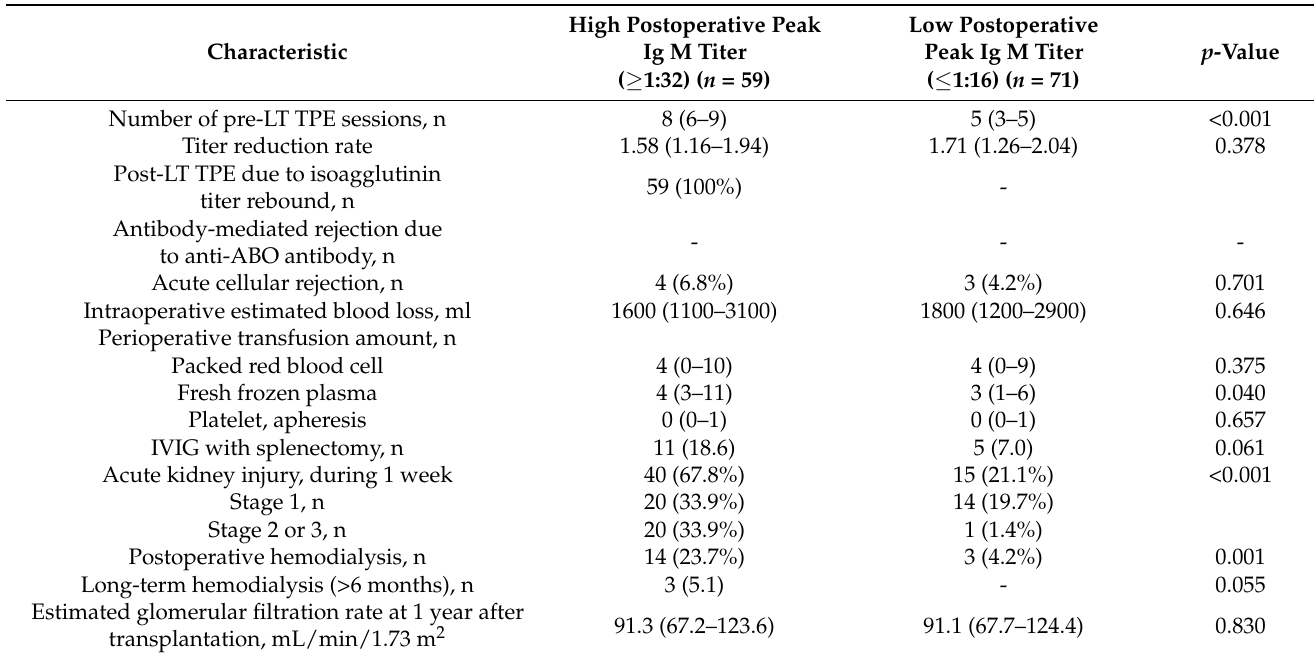
Table 4. Comparison of plasma exchange-related parameters and post-transplant outcomes between patients with high and low postoperative peak Ig M isoagglutinin